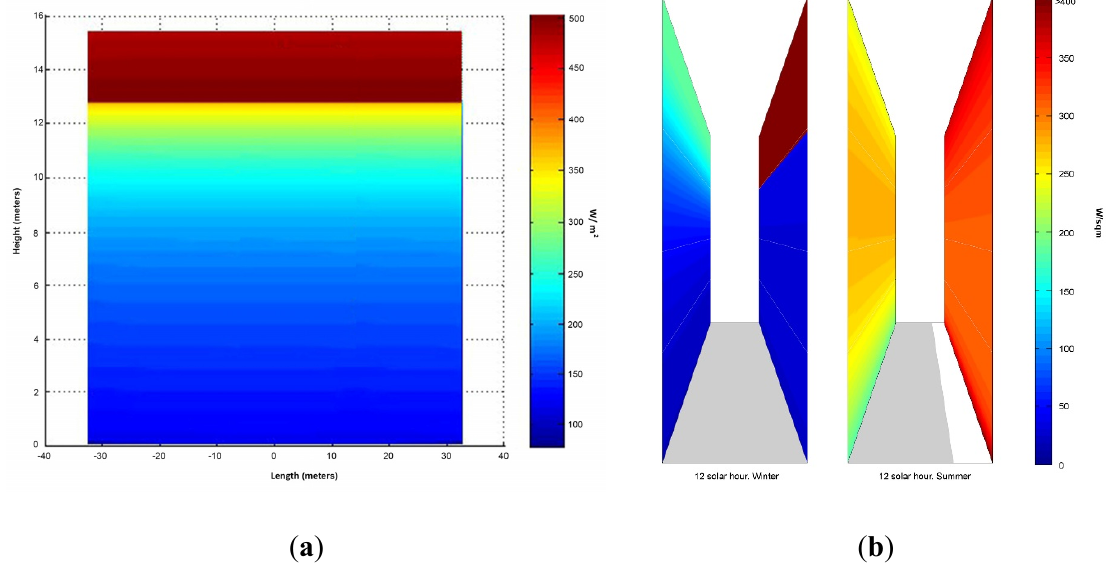
Figure 5. ( a ) Output example surface grafic, Winter 12 solar hour, Façade S-E 118°, H = 15.50 m, W = 4.00 m, L=65 m. Cadiz, Spain; ( b ) Simulation of façades. Winter and Summer 12 solar hour.